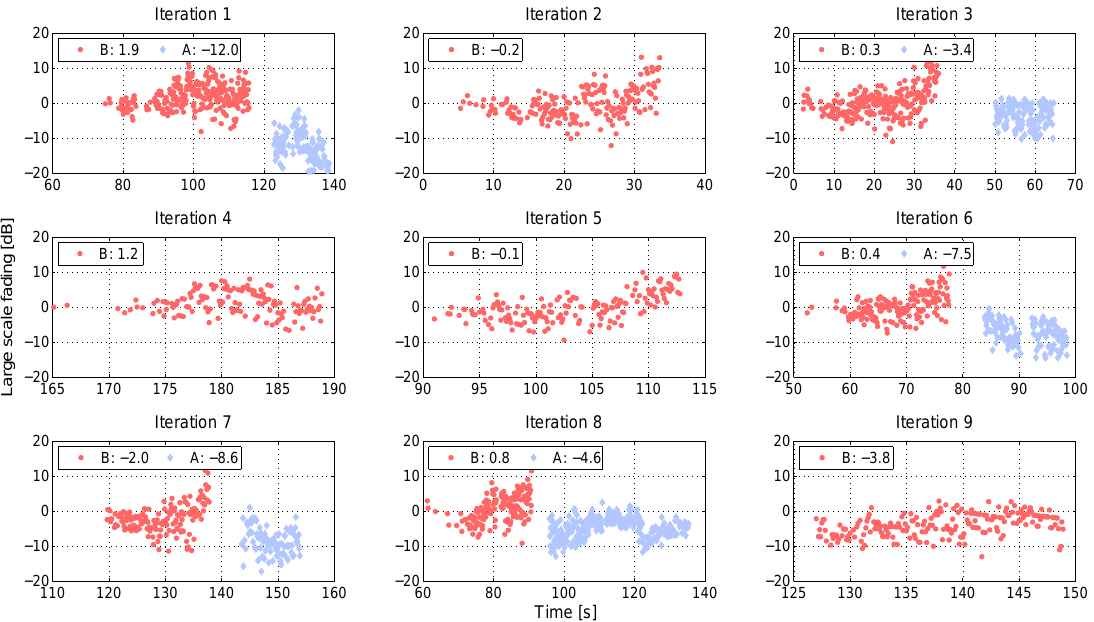
Figure 8. Large scale fading (LSF) of the NLOS communication link between XC90 Black Front and Truck Gold Right at intersection Yngve before (A) and after (B) the intersection. In all of the iterations, there was NLOS communication before the intersection and in some of the iterations, there was also NLOS communication after the intersection, i.e., when the XC90 Black car had passed the intersection. The numbers in each subfigure represent the offset between the mean of the specific LSF process from zero.